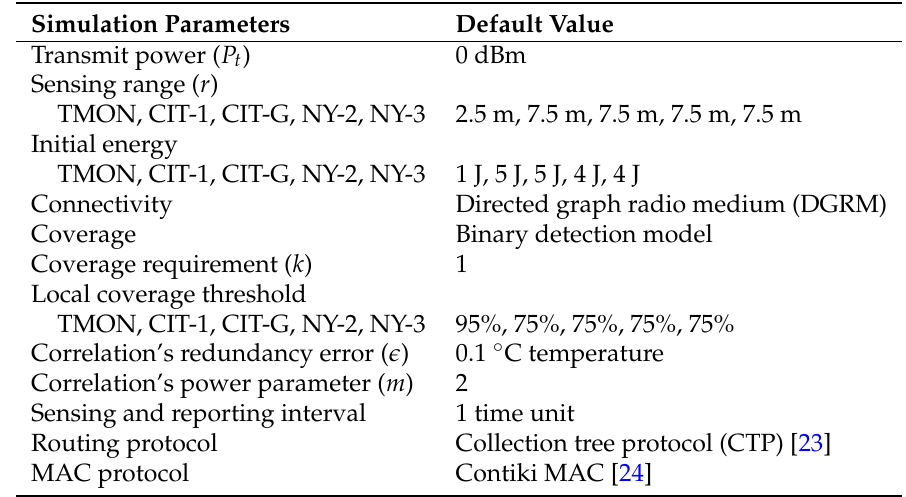
Table 6. WSN-Maintain simulation